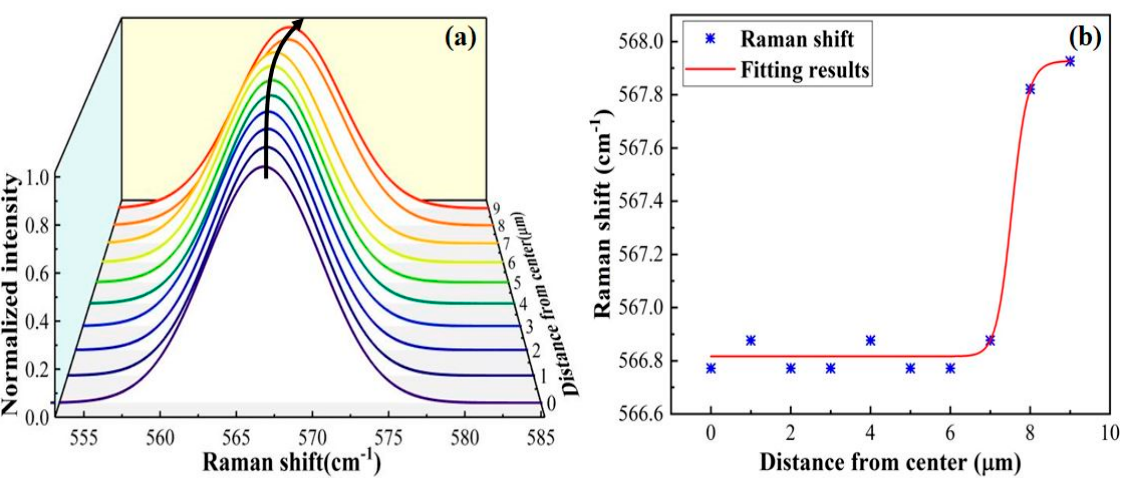
Figure 5. ( a ) E 2H modes of Raman spectra after Gaussian fitting and normalization at different dis- tances from center; ( b ) E 2H peaks at different distances from the center.